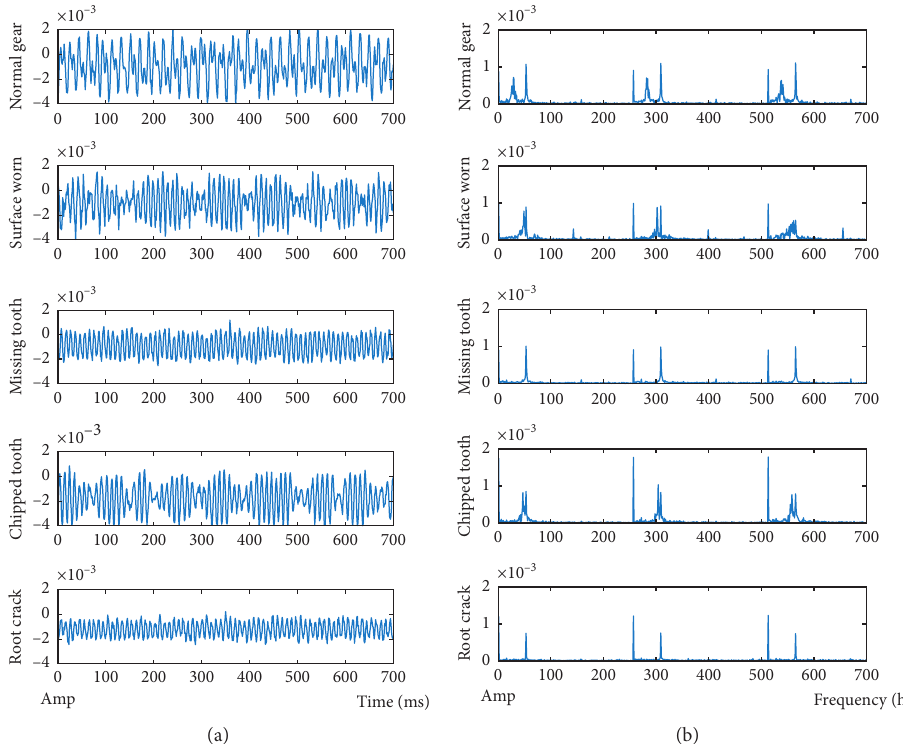
Figure 7: Vibration signals. (a) Vibration signal in time domain. (b) Vibration signal in frequency domain.